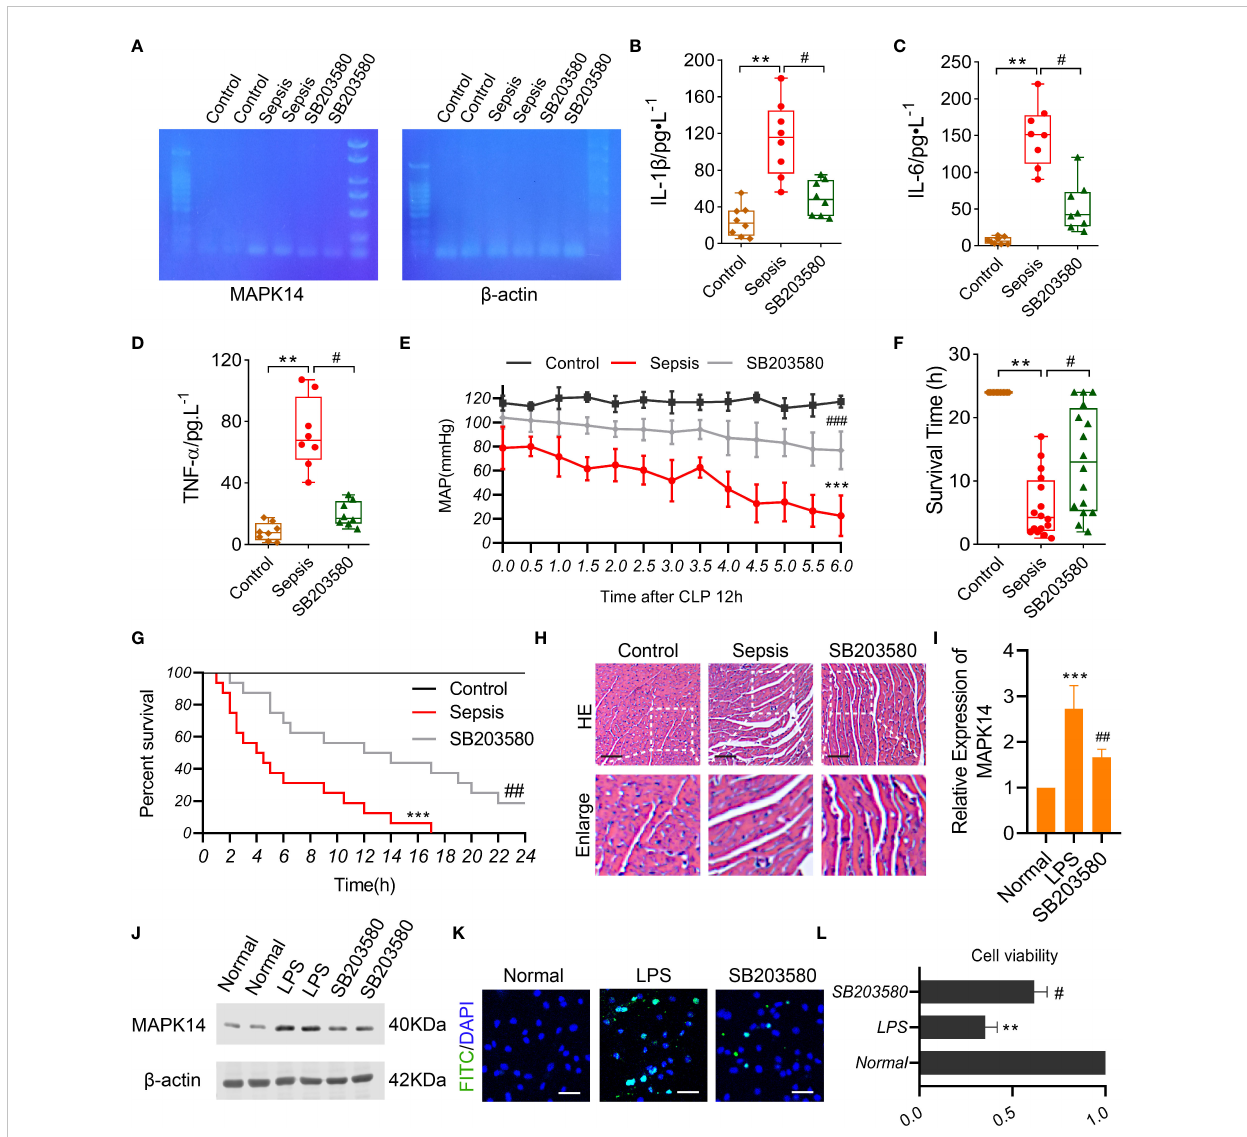
FIGURE 8 The role of MAPK14 in sepsis rats and LPS-induced cardiomyocytes. (A) RT-PCR detecting the inhibitory effectiveness of SB203580 on MAPK14 in heart tissues. ELISA showing the levels of (B) IL-1 b , (C) IL-6, and (D) TNF- a between three groups. (E) MAP within 6h detecting starting at 12h after CLP. (F) The survival time and (G) rate of rats. (H) Representative HE staining images of myocardial fi bers. (I) Quanti fi cation of Western blotting results of MAPK14. (J) Representative Western blotting images of MAPK14. (K) Representative TUNEL staining images of H9C2 cells. (L) CCK-8 detecting the cell viability of H9C2 cells. **: as compared with the Control or Normal group, P < 0.01; ***: as compared with the Control or Normal group, P < 0.001; # : as compared with the Sepsis or LPS group, P < 0.05; ## : as compared with the Sepsis or LPS group, P <